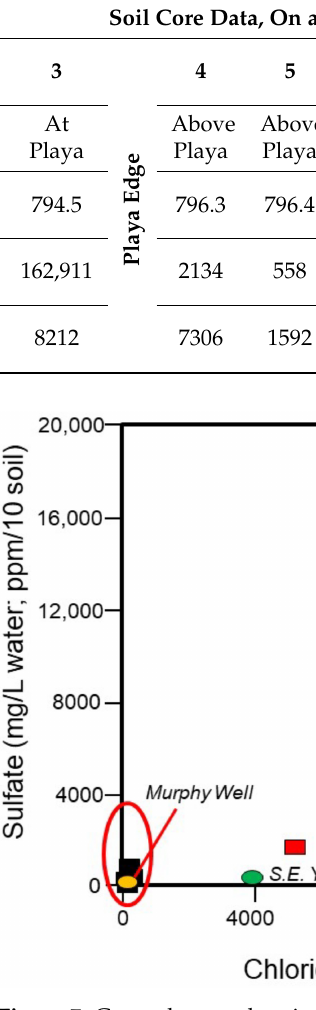
Figure 7. Groundwater chemistry data from dug wells at and above Ivanpah Playa (Table 2, from Waring, 1920) plotted against soil chemistry data from soil cores collected at and above Ivanpah Playa (Table 3, from [26]). On playa samples for groundwater and soils (see Figure 6) show a clearly related evaporite dissolution signature. Murphy well is an off-playa well sample upgradient from Ivanpah